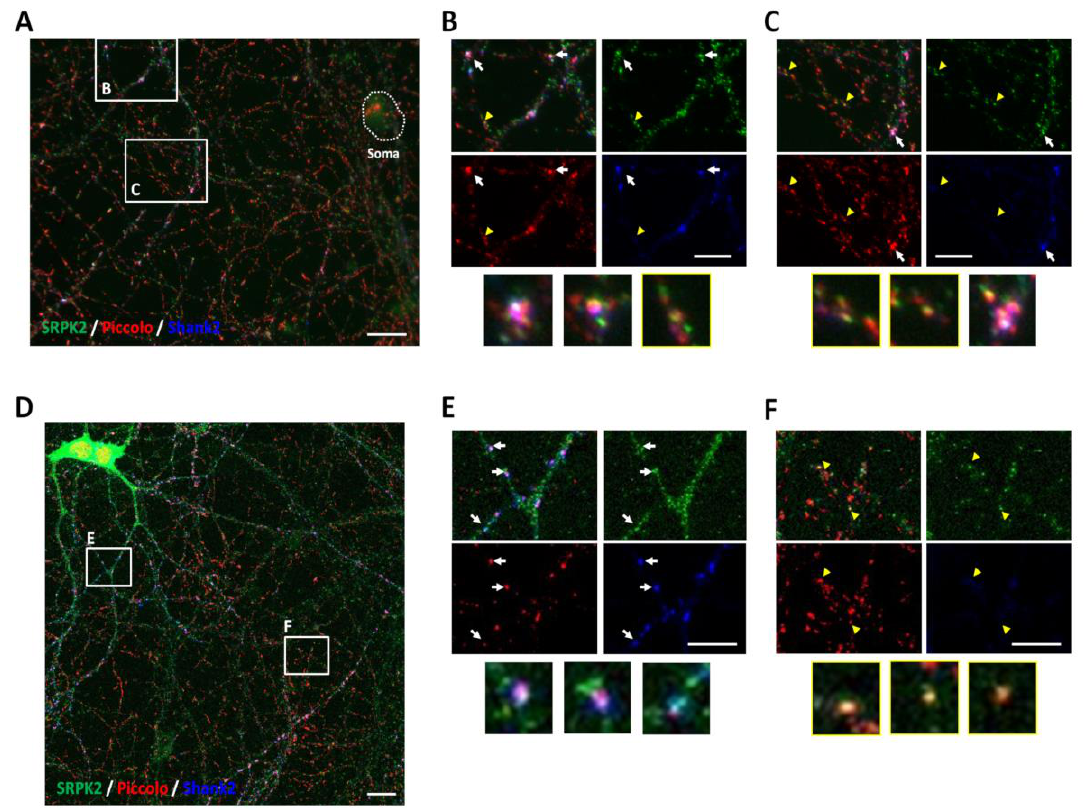
Figure 8. SRPK2 colocalizes with synaptic proteins in cultured hippocampal neurons. Representative images show neurites in dissociated rat hippocampal cultures. Neurons 21 DIV were triple stained using anti-SRPK2, anti-Piccolo and anti-Shank2 antibodies. Arrows indicate the co-distribution signal of SRPK2 with both Piccolo and Shank2, and arrowheads indicate co-distribution of SRPK2 only with Piccolo. ( A ) Low magnification and ( B , C ) high magnification of images acquired in an epifluorescence microscope. ( D ) Confocal images showing colocalization of SRPK2 with Piccolo and Shank2 (arrows), and only with Piccolo (arrowheads). ( E , F ) Digital magnifications of colocalization sites from ( D ). Scale bar: ( A , D ) 20 µm and ( B , C , E , F ) 10 µm.